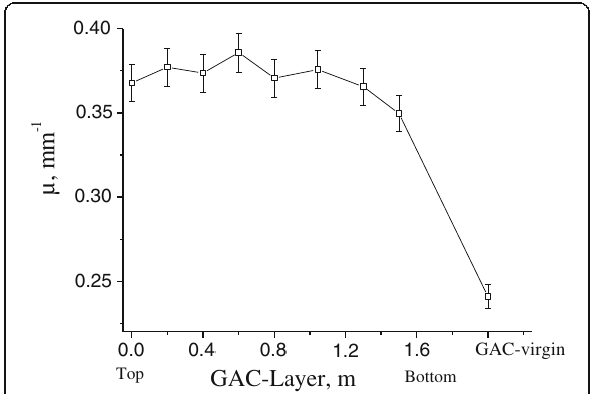
Fig. 9 Plot of the linear absorption coefficient ( μ ) at different GAC layers in the rum filter and the